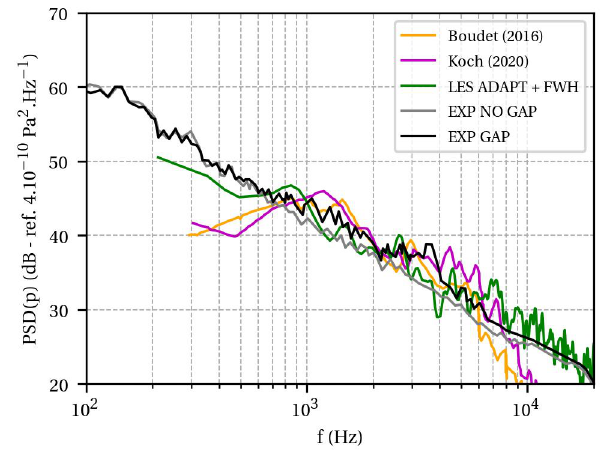
Figure 14. PSD of acoustic pressure 2-m away from the airfoil suction side, forming an angle of 90 ◦ with the airfoil